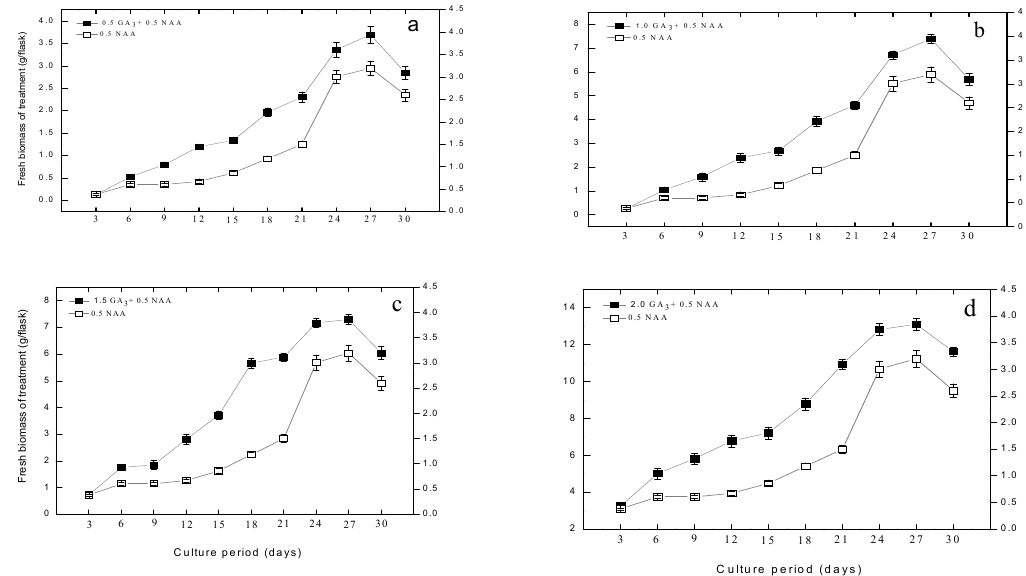
Figure 1. Fresh adventitious roots biomass accumulation in T1 (GA 3 0.5 mg/L + NAA 0.5 mg/L), T2 (GA 3 1.0 mg/L + NAA 0.5 mg/L), T3 (GA 3 1.5 mg/L), T4 (GA 3 2.0 mg/L) and control (0.5 mg/L NAA) media. In this experiment, the growth kinetics of S. rebaudiana adventitious root cultures was studied after 30 days of culture duration. The triplicate data in the mean along with standard errors (SE) are significantly different at p < 0.05.